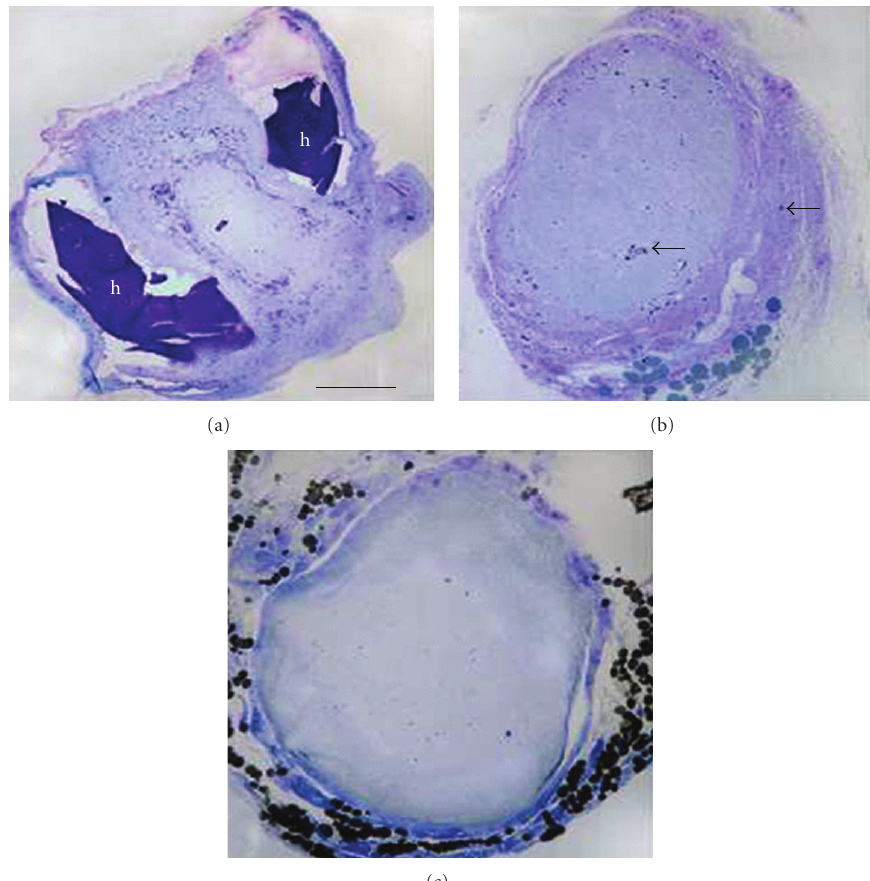
Figure 13: Toluidine-blue semithin transverse section of regenerating nerves in the medial part of the nerve guide at 30 (a), 90 (b), and 180 (c) days after surgery